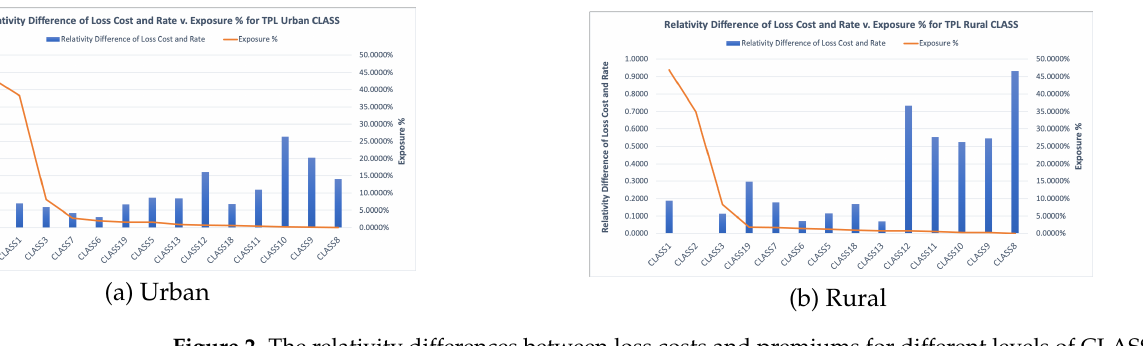
Figure 2. The relativity differences between loss costs and premiums for different levels of CLASS, and the percentage of risk exposures of the corresponding levels of CLASS for TPL coverage. Table 2. The average Euclidean distance of relativities between loss cost and premium, for DR and CLASS, by different coverages, territories and accident years.